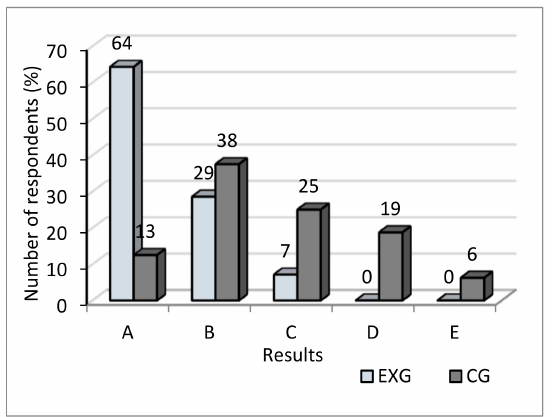
Figure 2. Post-test results in 2016/2017.